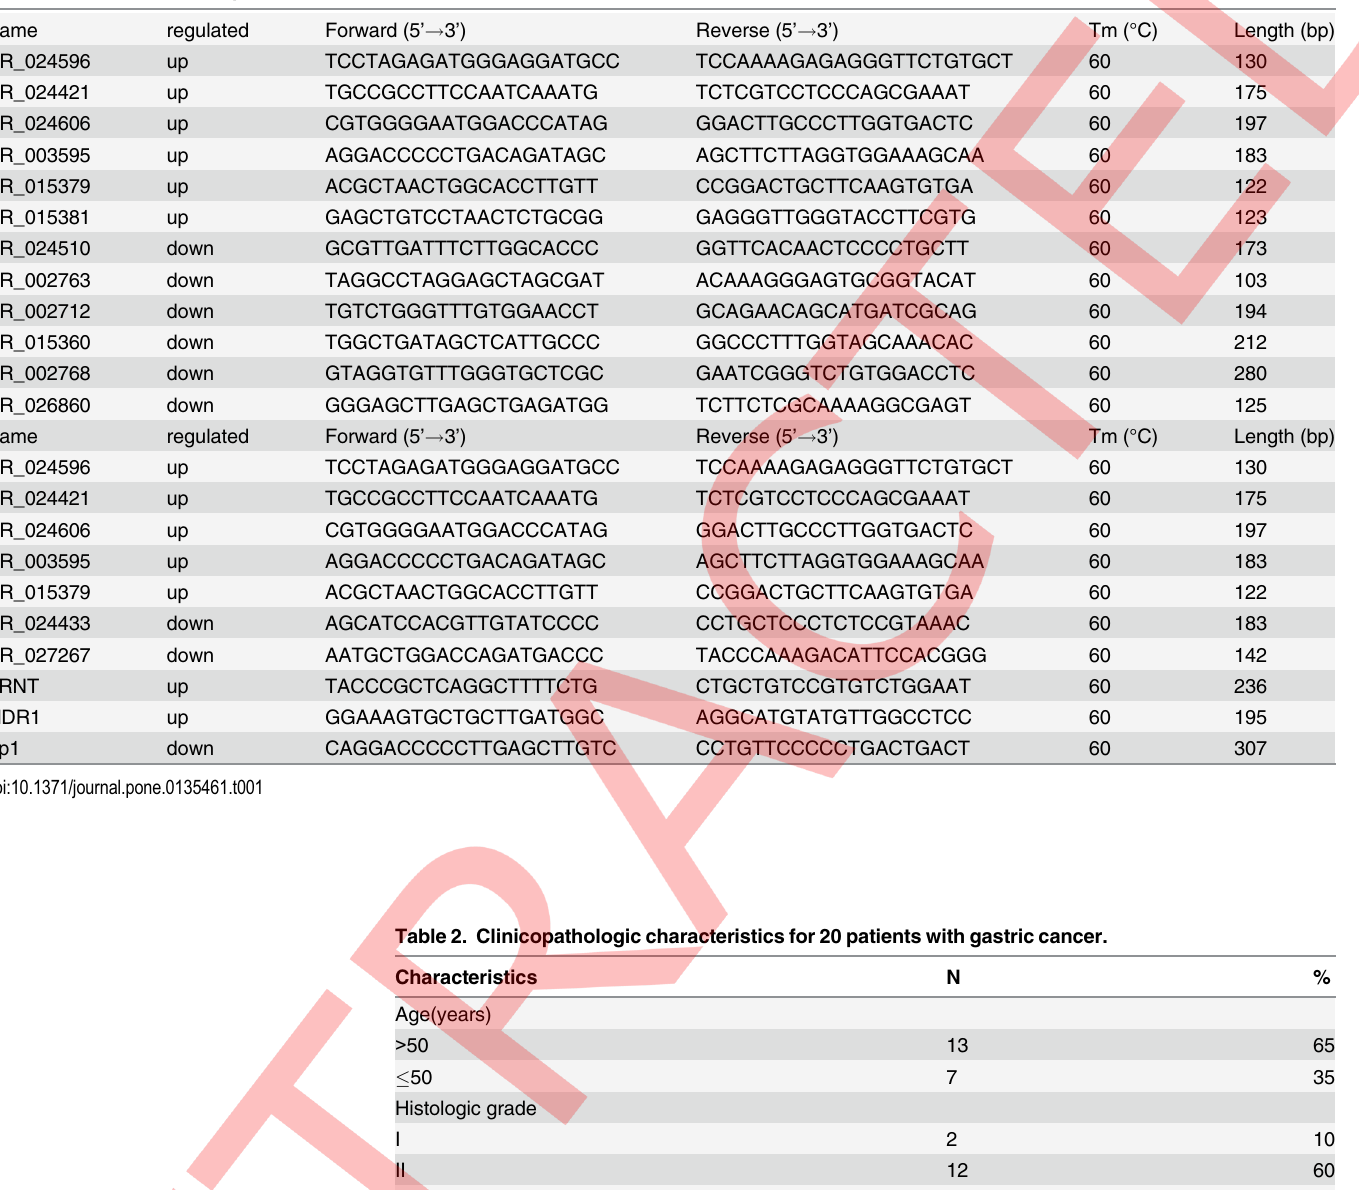
Table 1. Primers used for qRT-PCR.